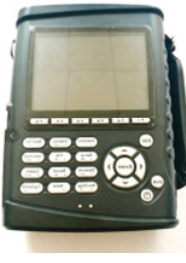
Figure 9. CoCo-90 dynamic signal analyzer.